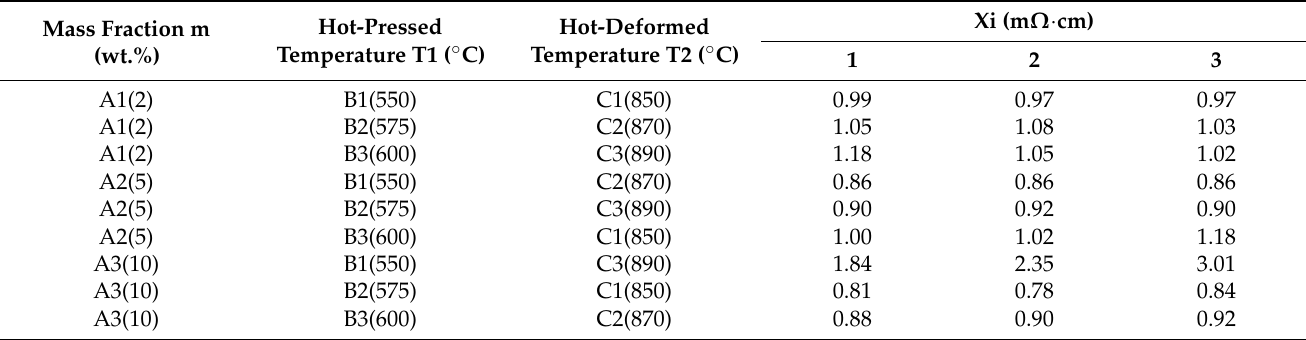
Table 2. Analysis of Variance.